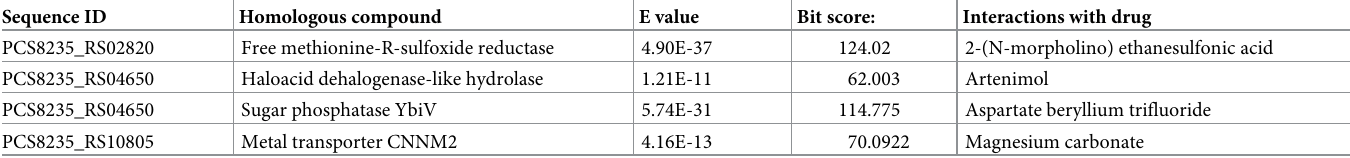
(Fig 7). The RMSF and SASA graphs of this protein showed that the binding of the drug altered mobility and solvent accessibility in the protein (Figs 8 and 9). Rg analysis unveiled that the compactness of the protein and drug-protein complex was most of the time similar during the simulations (Fig 10). For PCS8235_RS04650 and PCS8235_RS04650-drug bound complexes also gave similar results. The RMSD backbones did not overlap most of the time through 100ns. The RMSF values or mobility with protein compactness (Rg) of the structures altered due to drugs. Slight solvent accessibility was observed in SASA analysis. Table 5. Homologs of selected HPs found interacting with existing drugs in Drug Bank. Sequence